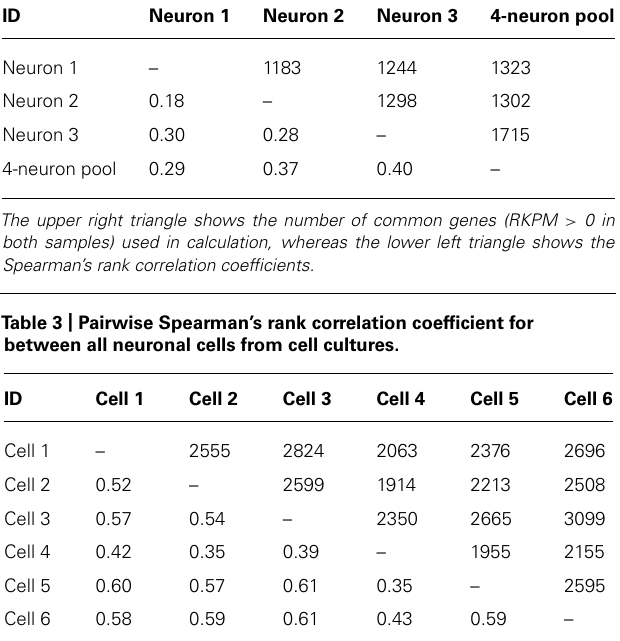
The upper right triangle shows the number of common genes (RKPM > 0 in both samples) used in calculation, whereas the lower left triangle shows the Spearman’s rank correlation